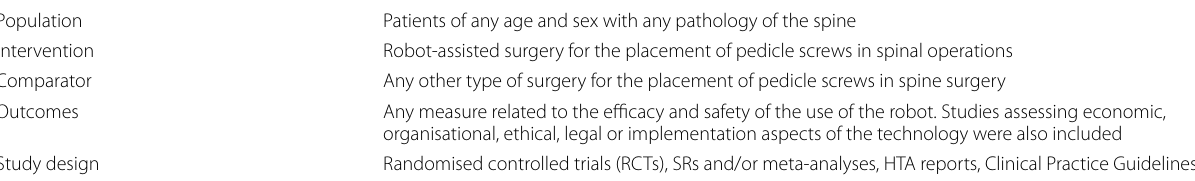
Table 1 Inclusion criteria according to the PICOS scheme Population Patients of any age and sex with any pathology of the spine Intervention Robot‑assisted surgery for the placement of pedicle screws in spinal operations Comparator Outcomes Study